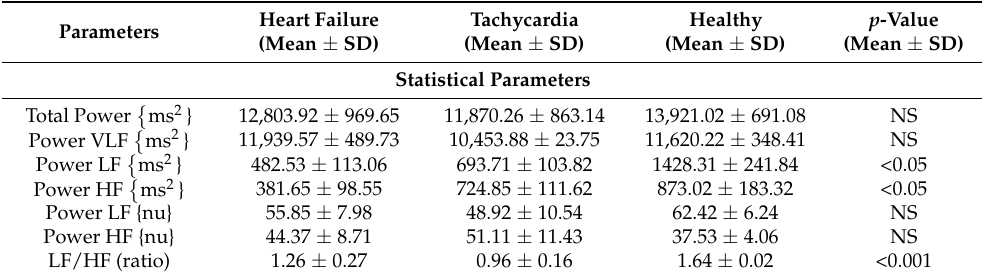
Table 5. Parameters in the frequency domain of the studied